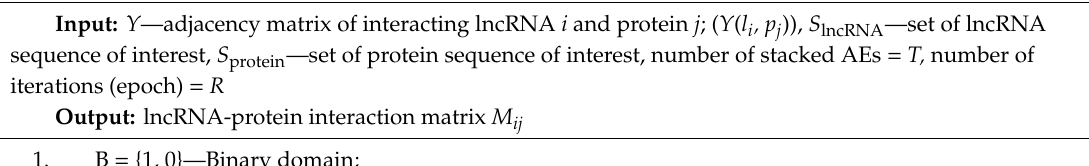
Algorithm 1: Pseudo code of PLRPIM